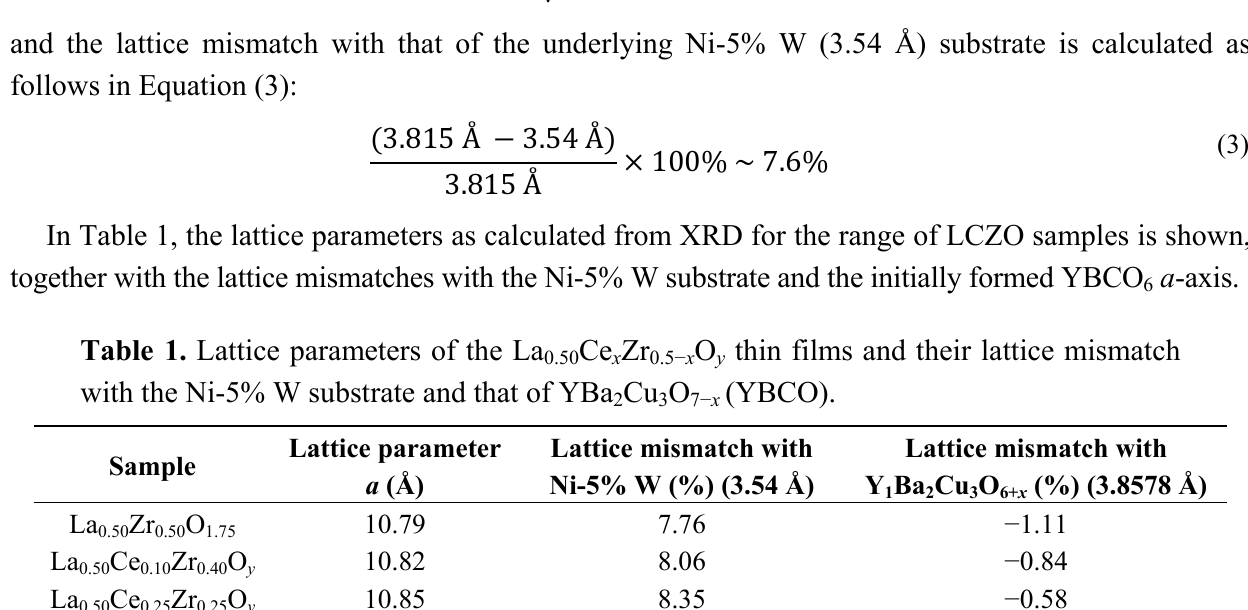
Table 1. Lattice parameters of the La